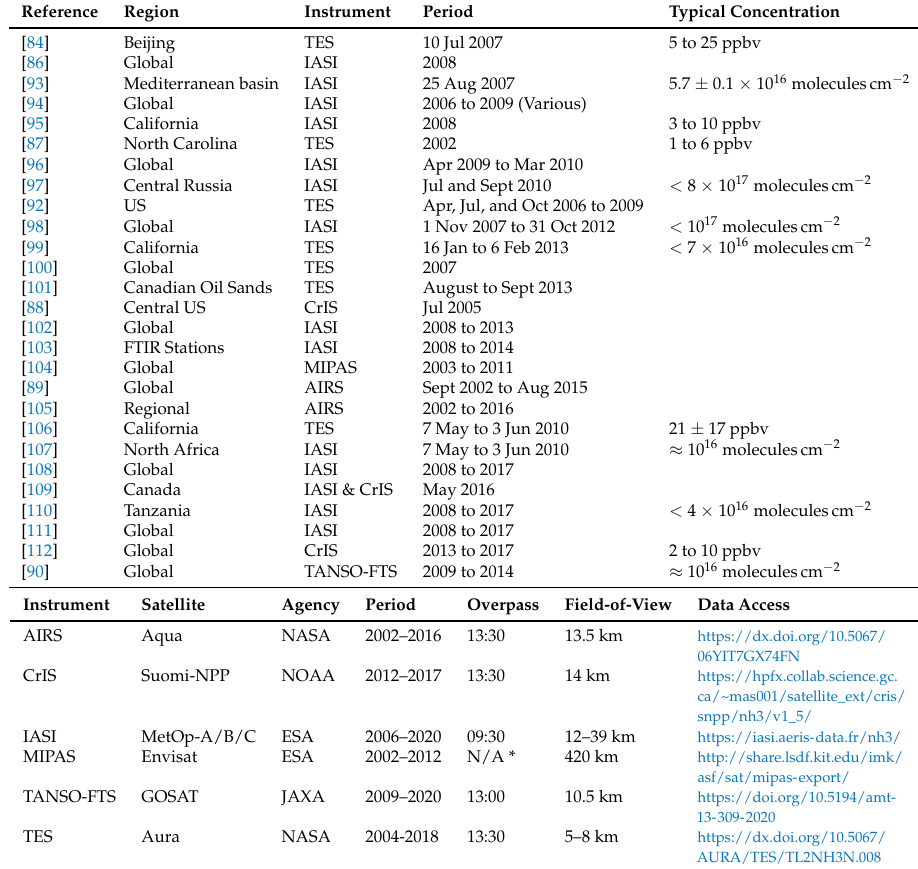
Table 2. Some satellite remote sensing studies of atmospheric NH 3 and instrumentation details.